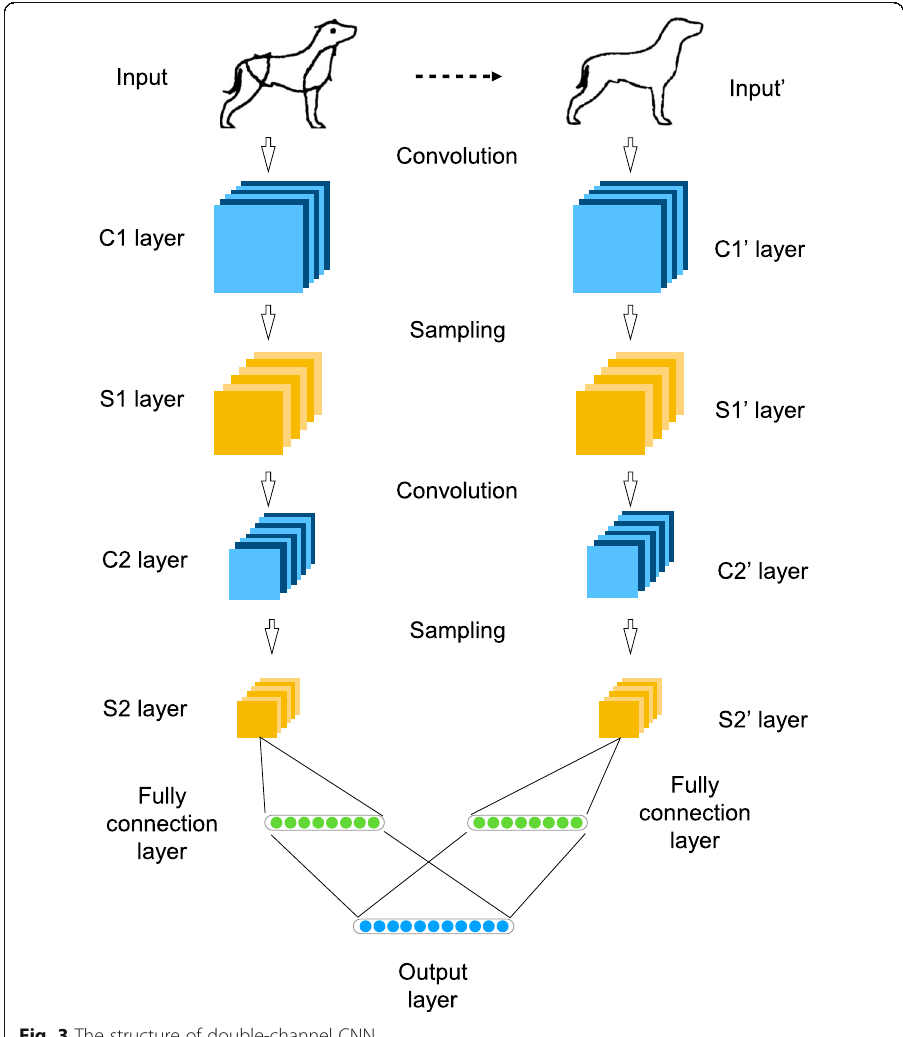
Fig. 3 The structure of double-channel